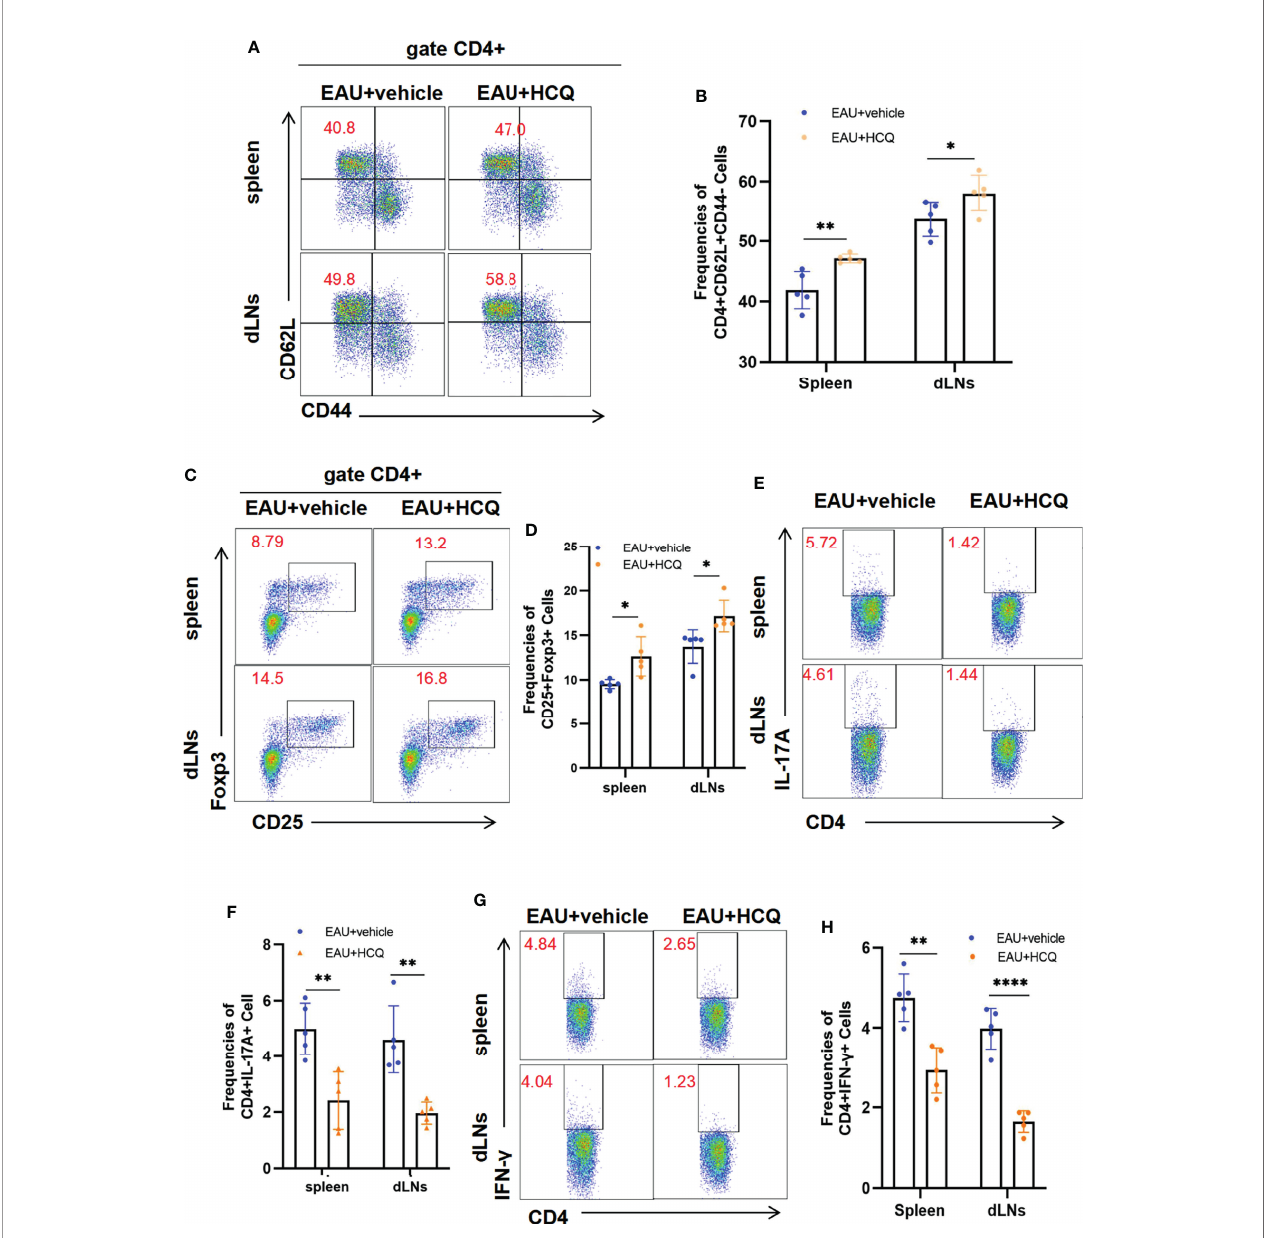
FIGURE 2 | Hydroxychloroquine (HCQ) maintains systemic Teff/Treg balance to ameliorate experimental autoimmune uveitis (EAU). The lymphocytes were isolated from the spleens and draining lymph nodes (dLNs) of C57BL/6J mice on day 14 after immunization (N=5). Flow cytometry experiments were gated on CD4 + cells. (A, B) HCQ inhibited the naïve CD4 + T cell (CD62L+CD44-) differentiation into memory CD4 + T cells (CD62L-CD44+) compared with EAU treated with the vehicle, in both spleens and dLNs. (C, D) The proportion of Treg cells in spleens and dLNs was promoted by HCQ administration in EAU mice. (E ‐ H) HCQ decreased the frequencies of Th1 and Th17 cells in spleens and dLNs. The data are presented as the mean ± SD. (*P < 0.05, **P < 0.01, ****P <